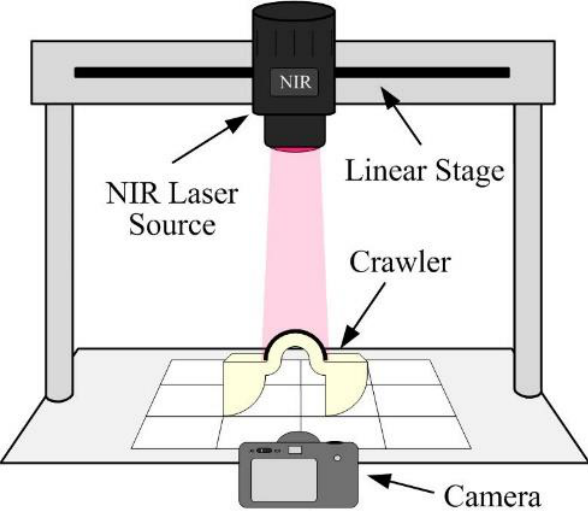
Figure 9. The experimental setup for measuring the crawling locomotion of devices.